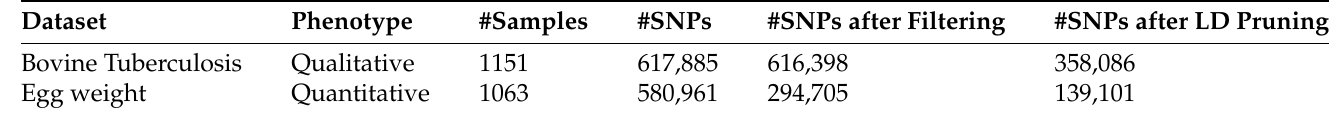
Table 1. Overview of the datasets used in our study.